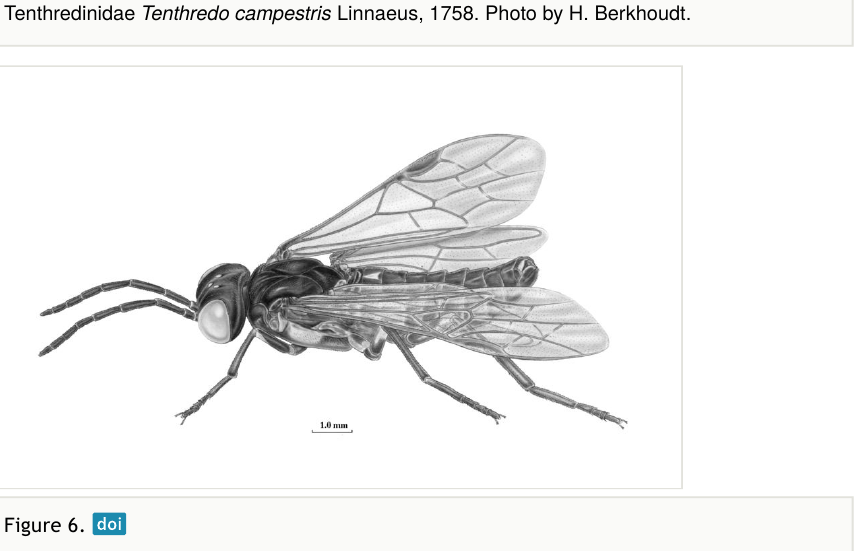
Tenthredinidae (Tenthredininae) Latreille, 1802. Drawing by Bas